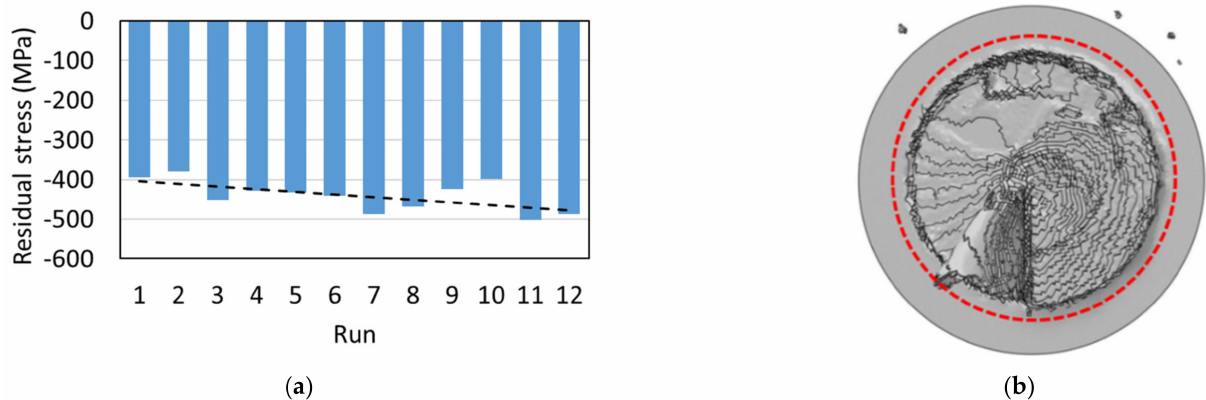
Figure 14. Influence of the cutting conditions on the average residual stress ( a ) and representation of the evaluated subsurface volume ( b ).